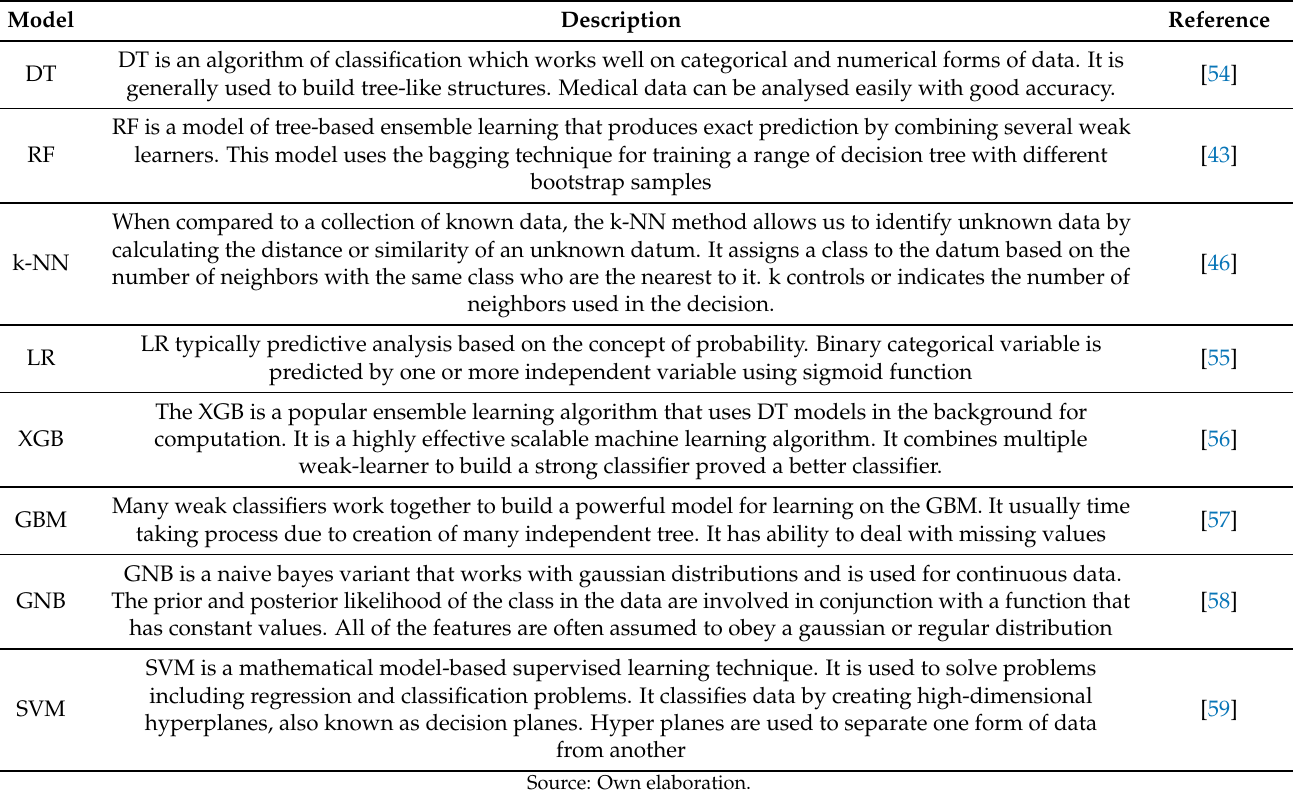
Table 6. Machine Learning